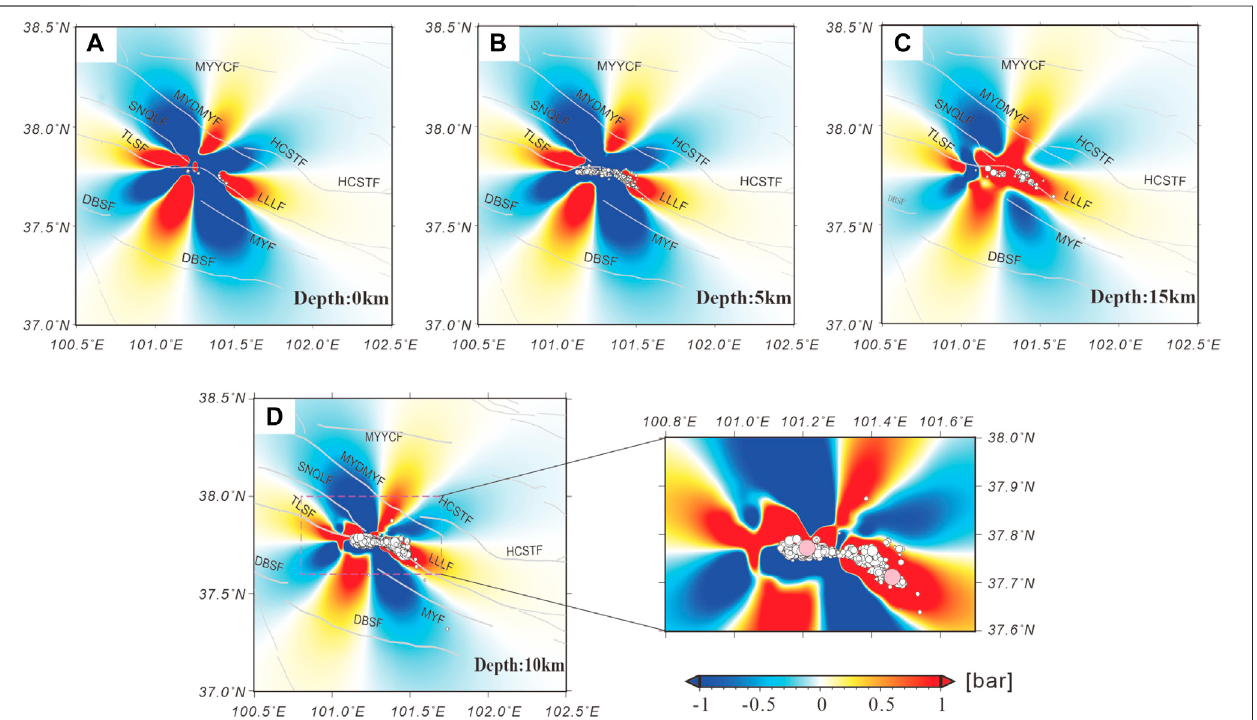
FIGURE 12 | Regional co-seismic static Coulomb stress changes at different depths. (A – D) represent the changes of static Coulomb stress at depths of 0, 5, 15, and 10 km,respectively. Whitecirclesrepresent aftershocksin10 daysafter theearthquake,including two M ≥ 5aftershocks(pinkcircles) (Yang etal.,2022),whichare located at the speci fi ed depth within 2 km up and down; the gray solid lines indicate the fault traces in this area.